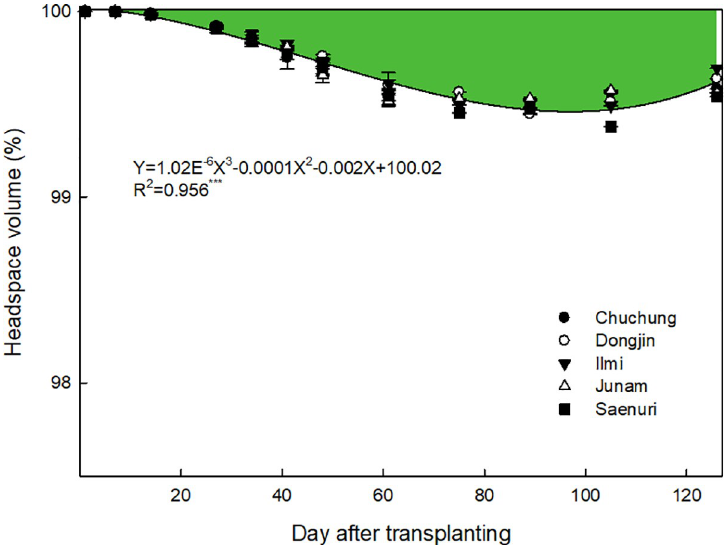
Fig 3. Changes in the headspace volume inside closed chamber during rice cultivation period. Green color indicates the allocation (%) of plant biomass inside the closed chamber headspace.